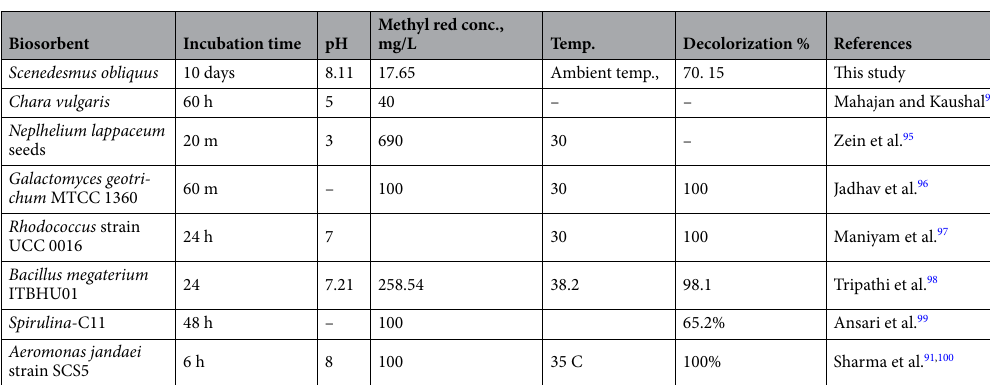
Table 6. Optimization factors for decolorization of methyl red dye from aqueous solutions by various biosorbents.